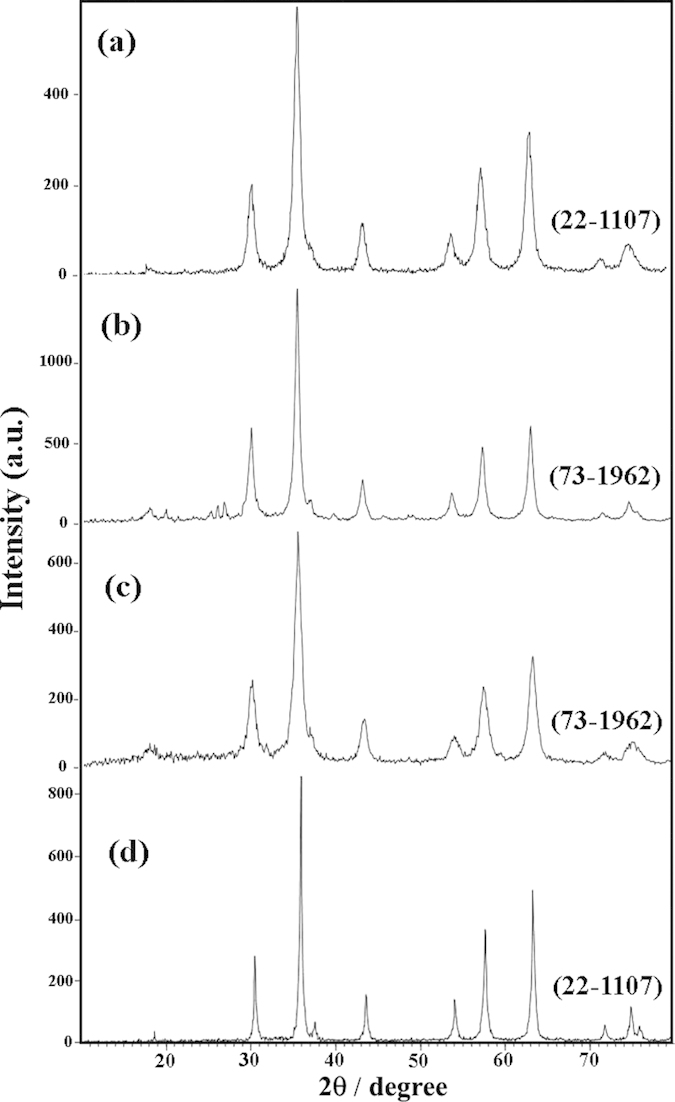
(Ahν)2 - hν curve for ZnCr2O4 nanoparticles (sample 4).